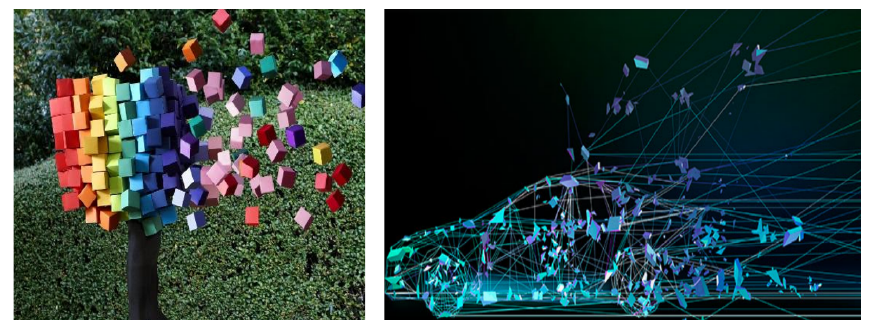
Fig. 3 - Blocks – a seamless operation represents an array of functions converging from diverse partner companies 46 illustrations extracted from: left image from [ 3 ] and right image from [ 4 ] As it is with IoT, there will not be any one industry, or company, which may claim to be the front-runner. The modular building blocks, for the domains spanning and overlapping IoT, digital twins and blockchains (not limited to financial transactions) are quintessential to the global economy. The idea of a distributed team, or teams